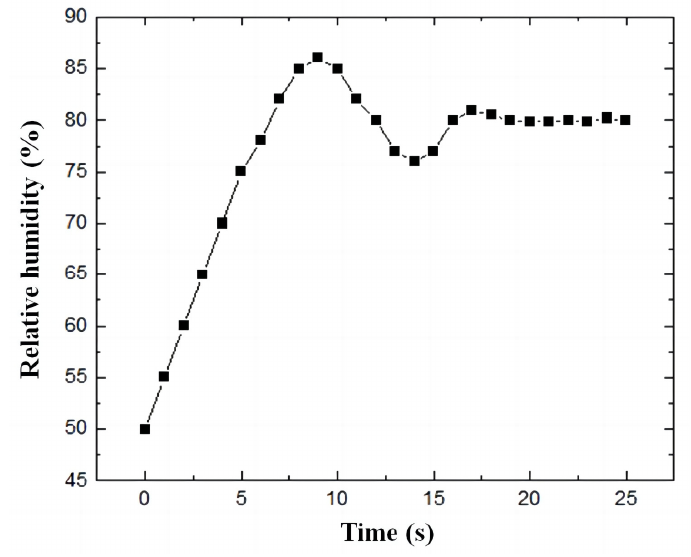
Figure 11. Variation curve of the relative humidity with time.